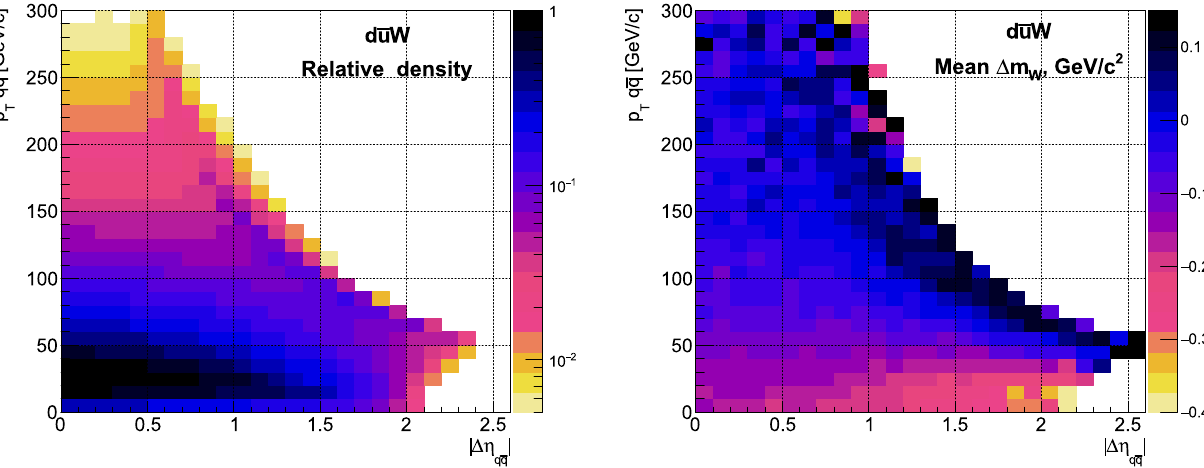
Fig. 12 The process WW → μ + ν du . Left is the relative density of the electroweak signal as a function of the | (cid:10)η | and p T of the quark pair. Right is the shift in the mean mass due to interference, as defined in the